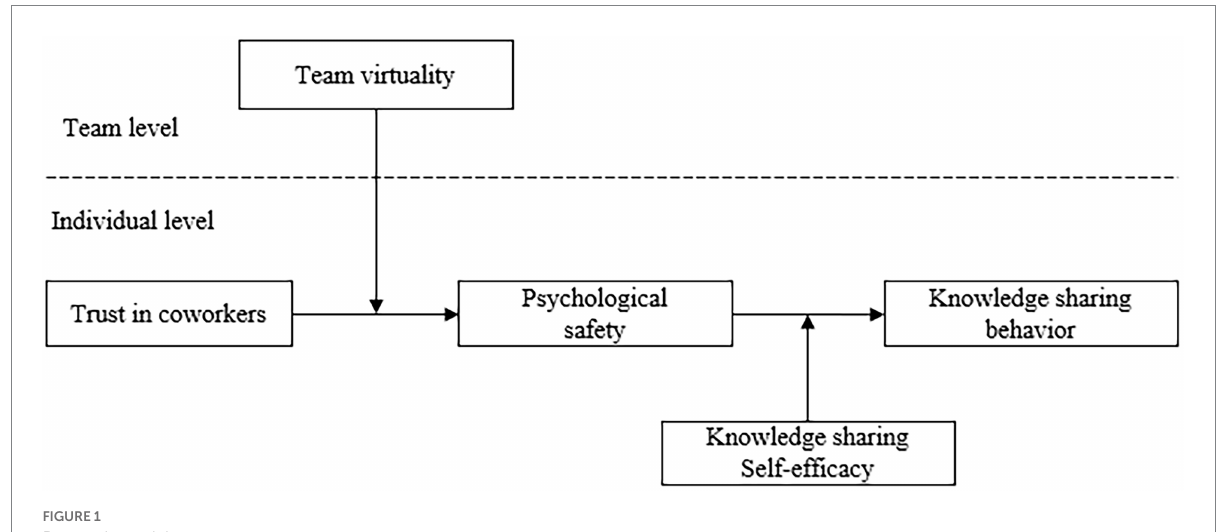
FIGURE 1 Research